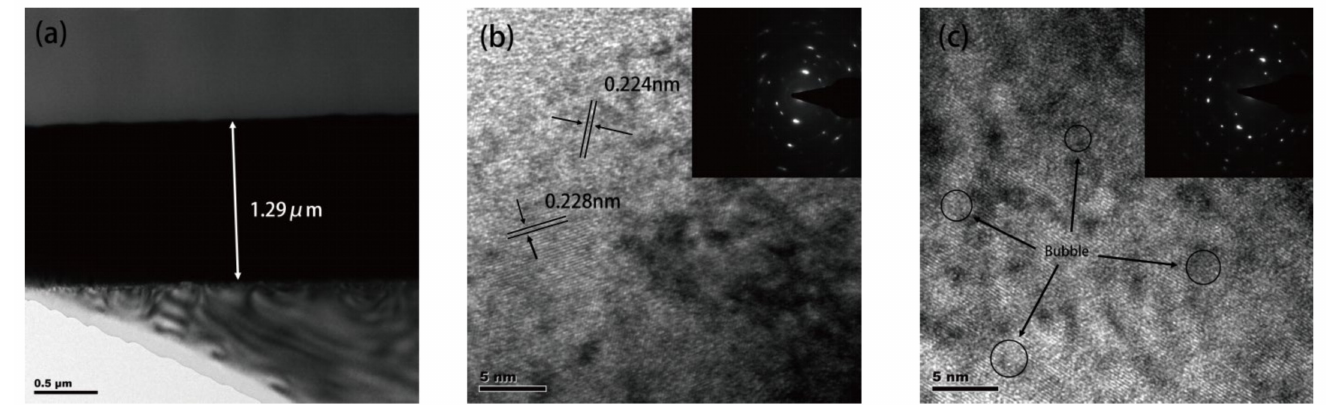
Figure 4. HRTEM and SAED images of sample C (Ta30W30Ti12V15Cr13): ( a ) cross-sectional view of the film; ( b ) before irradiation, and ( c ) at the peak damage depth after irradiation.